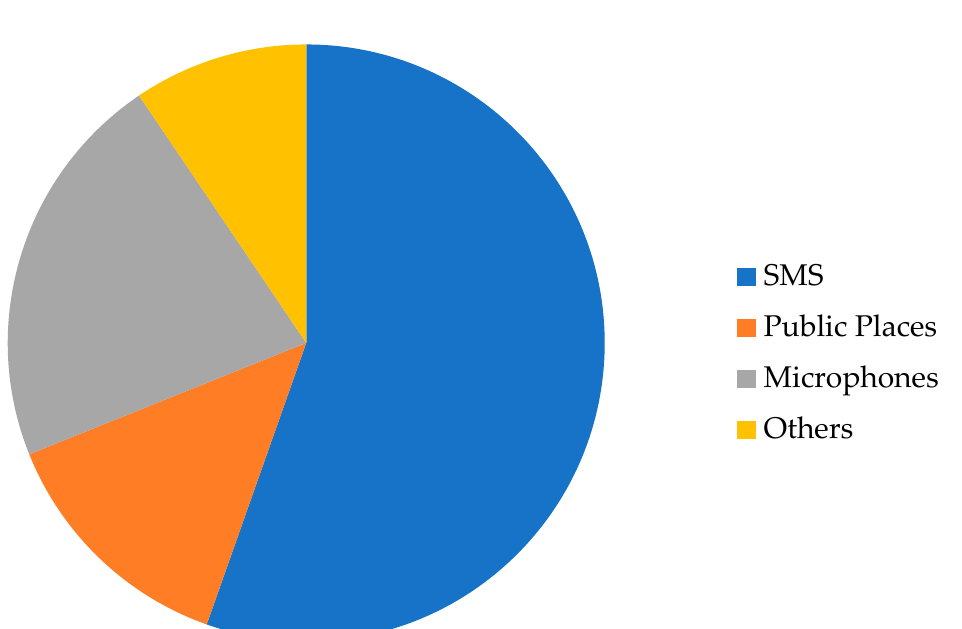
Figure 5. Expected means of communicating a FEW. Responses from the participants of this study.